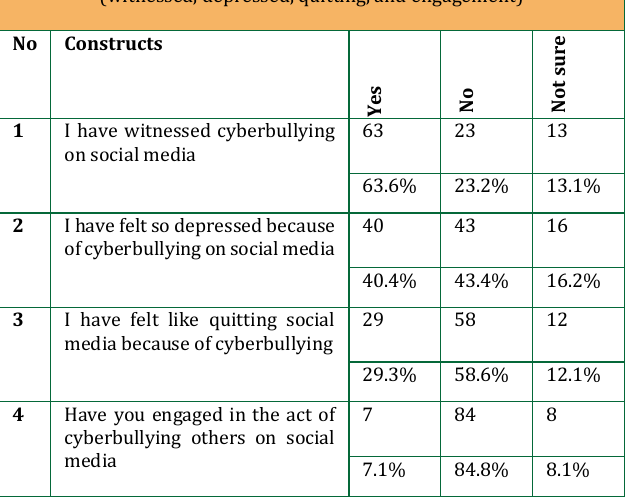
Table 2: The consequence of cyberbullying on social media (witnessed, depressed, quitting, and